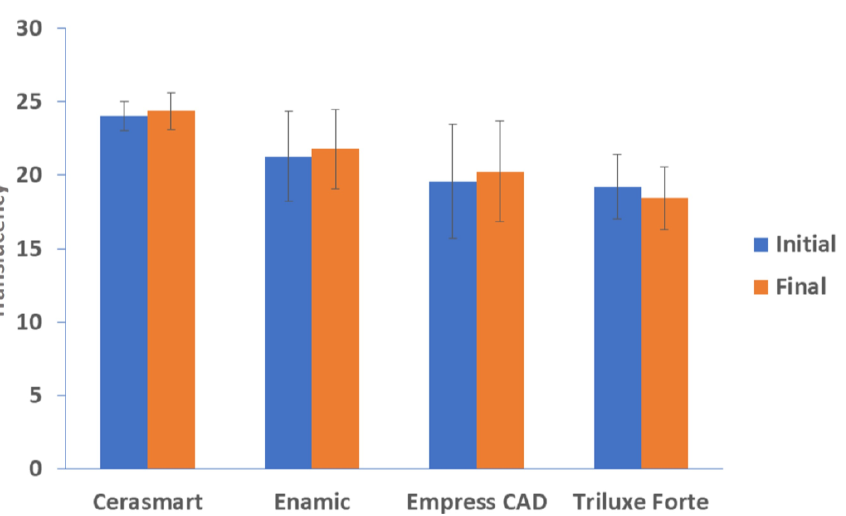
Figure 2. Comparison between the translucency parameters of four CAD-CAM monolithic materials, before exposure (initial) and after exposure (final).